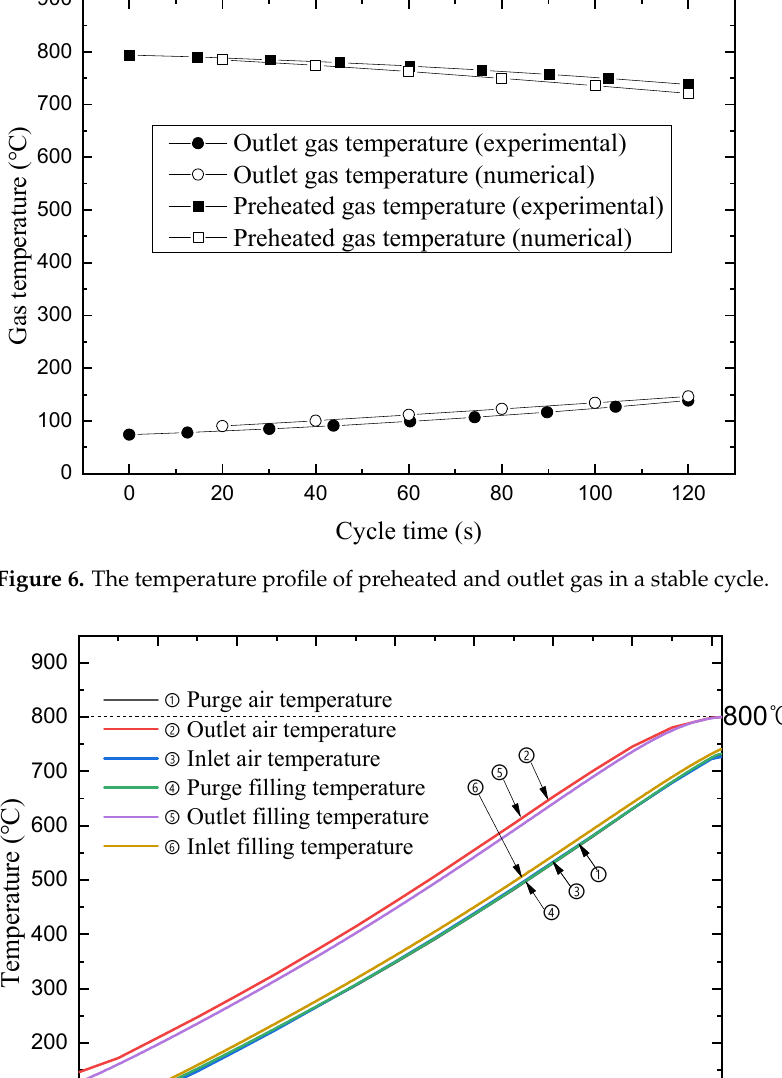
Figure 6. The temperature profile of preheated and outlet gas in a stable cycle.